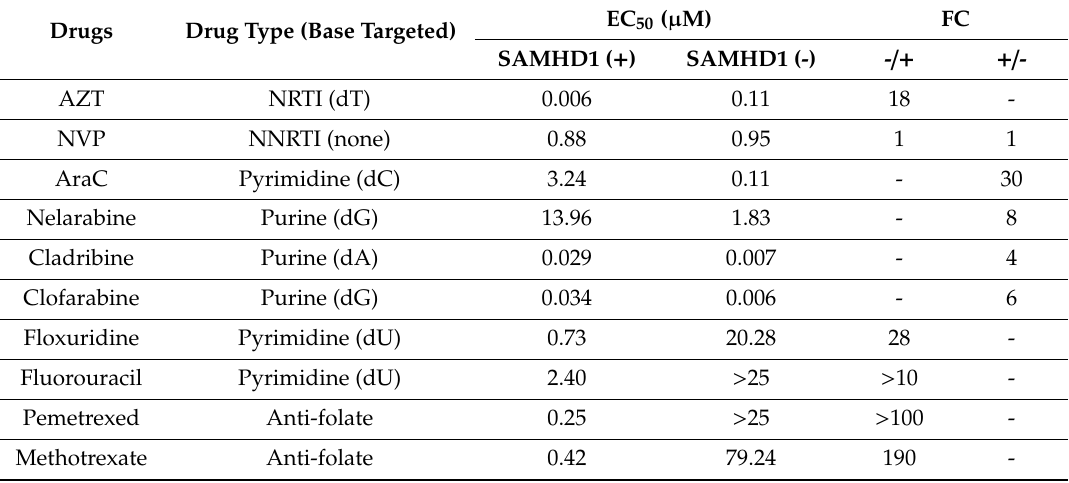
EC 50 ; E ff ective concentration required to block HIV-1 replication by 50%, FC; fold change or ratio of the EC 50 without SAMHD1 and the EC 50 with SAMHD1 (- /+ ), or inversely ( +/